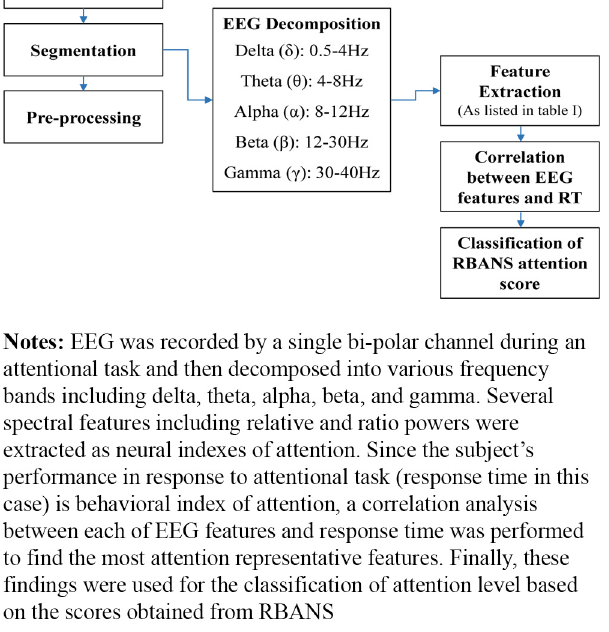
Figure 1. Schematic diagram of the overall